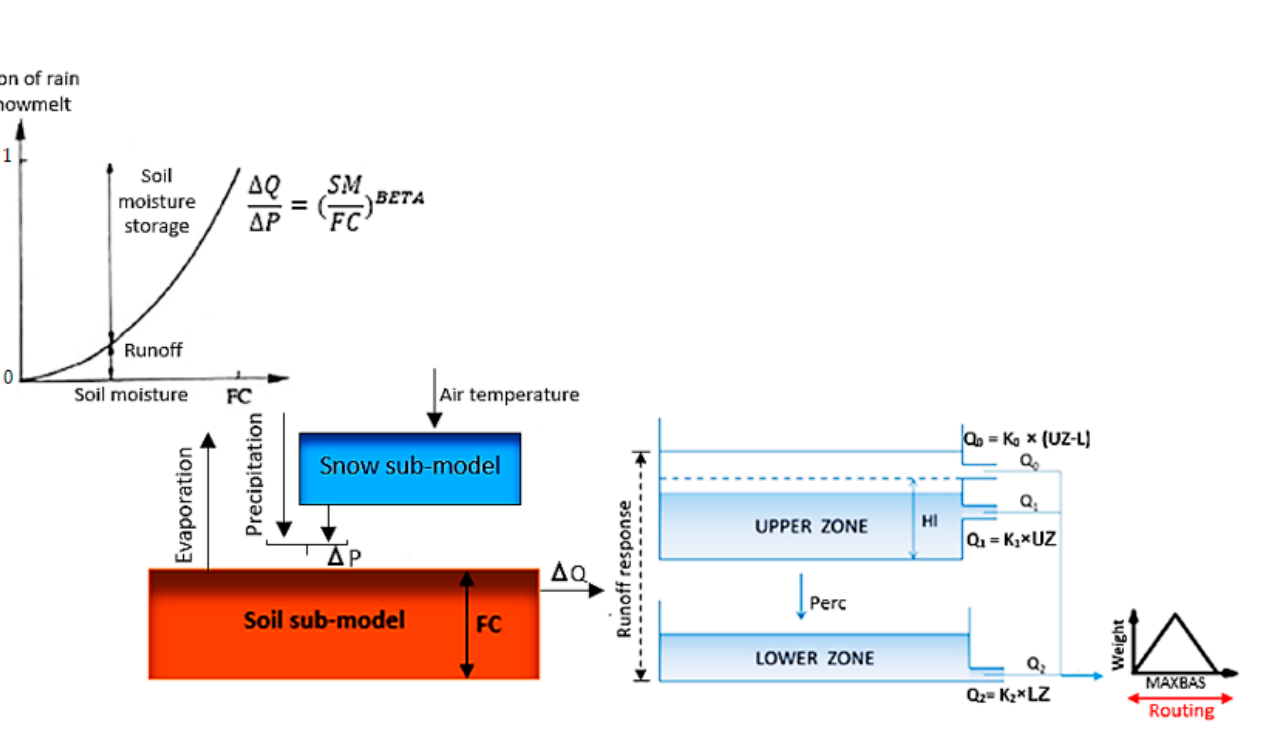
Figure 4. Schematic of the HBV model with main equations [41]. Table 3. Description of the HBV model parameters along with their